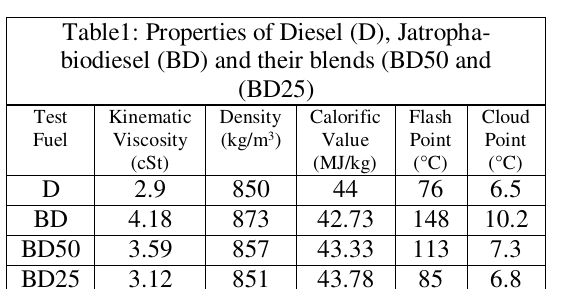
Fig. 2 depict test-setup and schematic diagram of 4-